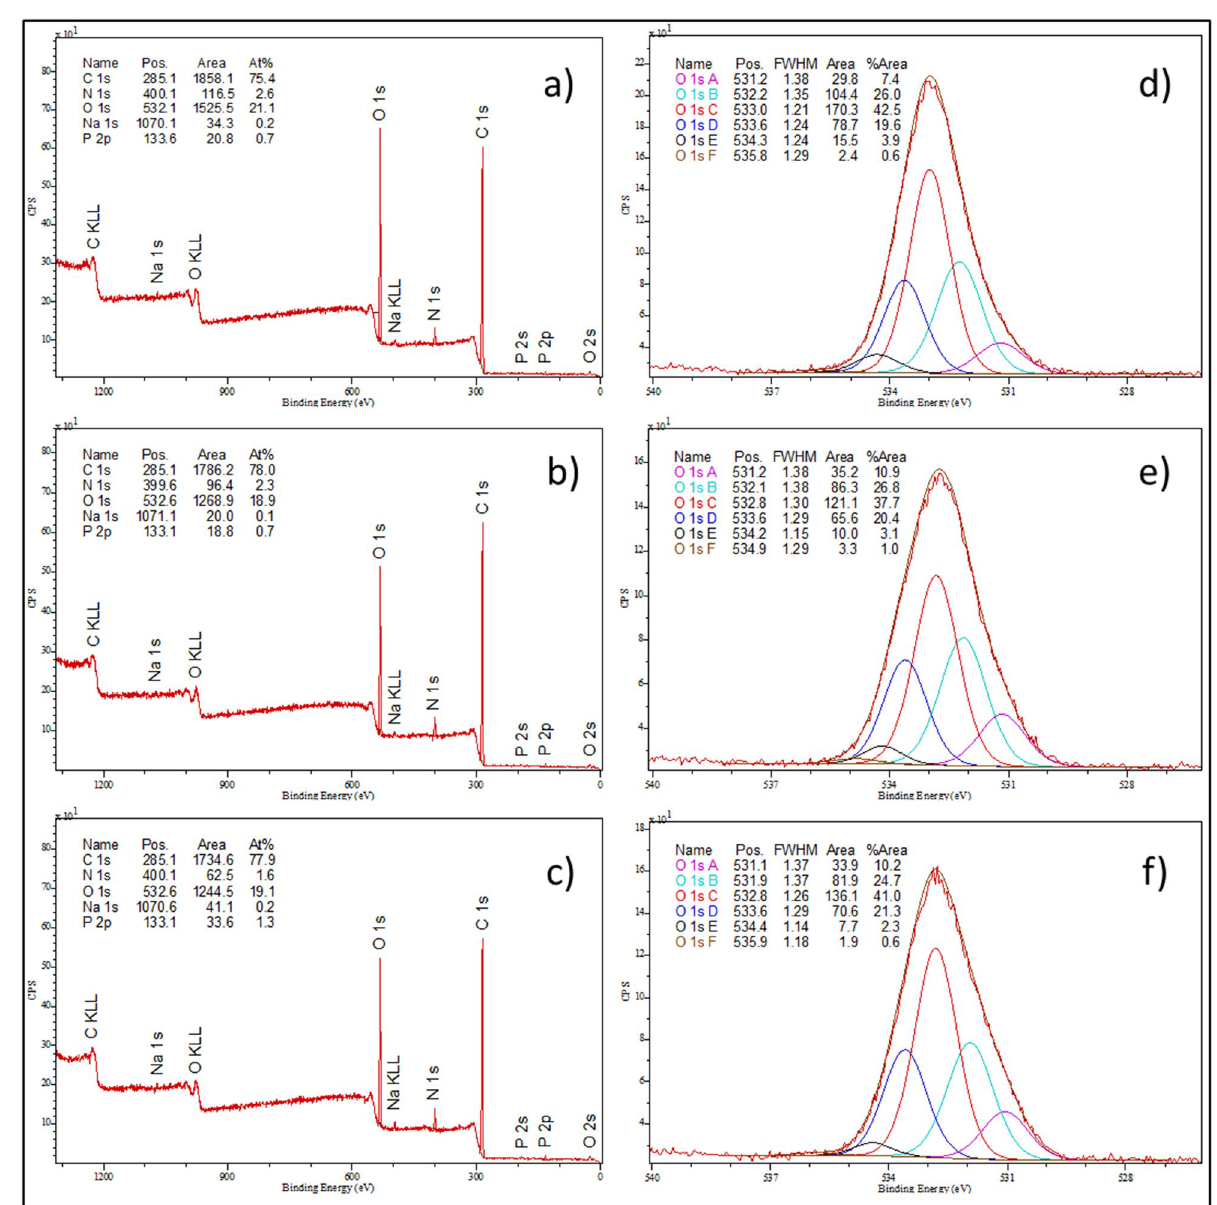
Figure 9. XPS spectra over a wide range of binding energies: ( a ) C. albicans control cells, ( b ) C. albicans cells incubated with AAF at a concentration of 50 µg mL −1 , ( c ) C. albicans cells incubated with AAF at 100 µg mL −1 ; XPS spectra in a narrow range of binding energies characteristic for oxygen: ( d ) C. albicans control cells , ( e ) C. albicans cells incubated with AAF at a concentration of 50 µg mL −1 , ( f ) C. albicans cells incubated with AAF at 100 µg mL −1